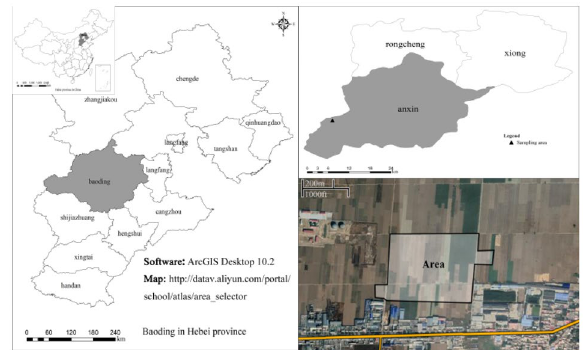
Figure 1. Geographical location map of research